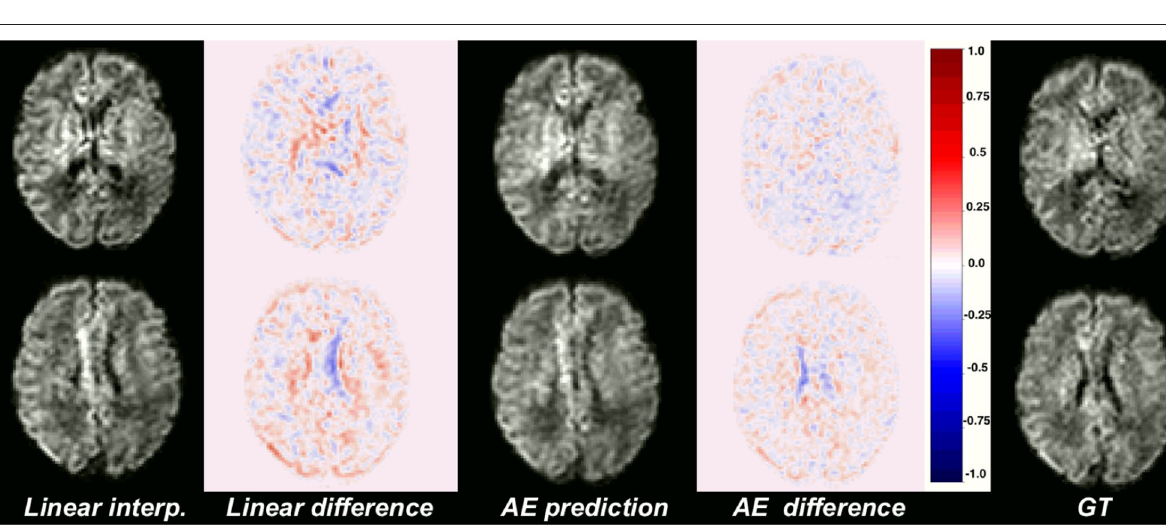
Figure 4 illustrates qualitative results and absolute errors for N = 1 with respect to the GT (right) between the best interpolation baseline (trilinear, left) and the autoencoder enhancement (middle) for b1000. We overall saw from these representative examples, higher absolute intensities in the Linear-1 configuration than in the AE- 1. However, ventricles are less visible when using an autoencoder. We hypothesize this is because of their higher intensity in b0 images on which the network was